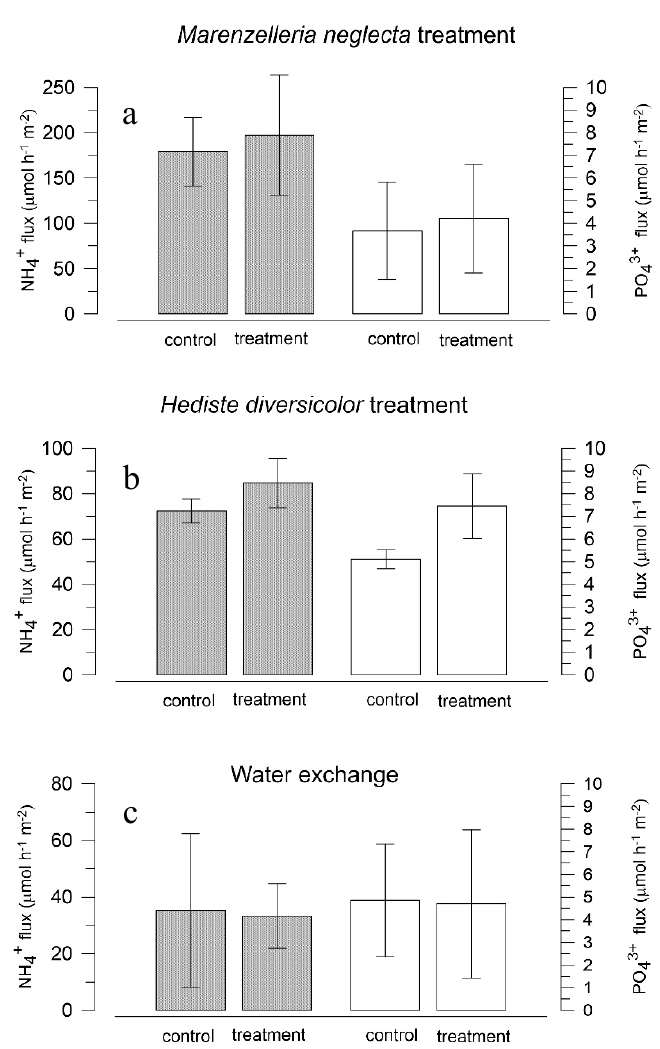
Figure 5. Effects of species additions and water exchange on the net dissolved fluxes of ammonia (closed bars) and phosphate (open bars) in experiment 2: ( a ) Marenzelleria neglecta -run 1, ( b ) Hediste diversicolor -run 2, ( c ) exchange of the overlying water-run 3. Values are the mean ± standard error for 3 replicate cores.